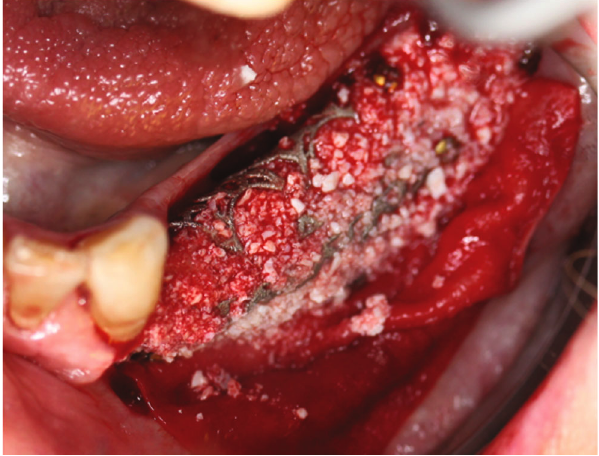
Figure 11: Bio-Gide® membrane stabilized in its position with titanium pins.